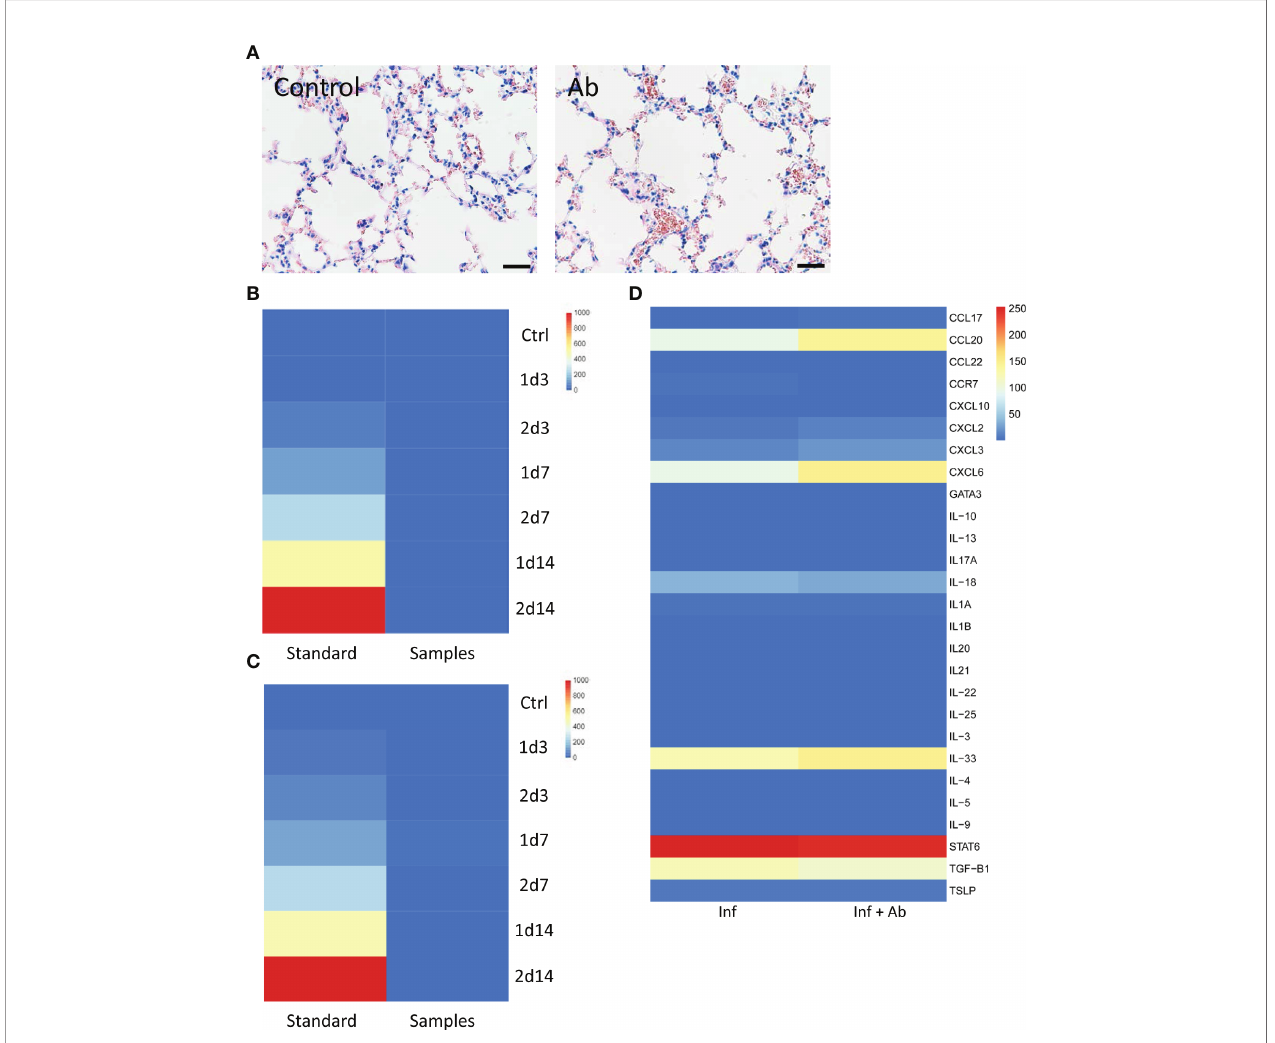
FIGURE 5 | Immune effects of the antibody. (A) H&E-stained lung sections from mouse that inhaled saline vs . anti-receptor-binding domain (RBD) polyclonal antibodies (pAbs). Scale bar: 80 m m. (B, C) Negligible secretion of major allergy-related cytokine interleukin (IL)-13 detected in the presence of pAbs in vivo in the (B) inhalation intake model and (C) tail intravenous injection model. (D) Heatmap of immune markers from organoid RNA sequencing (RNA-seq)